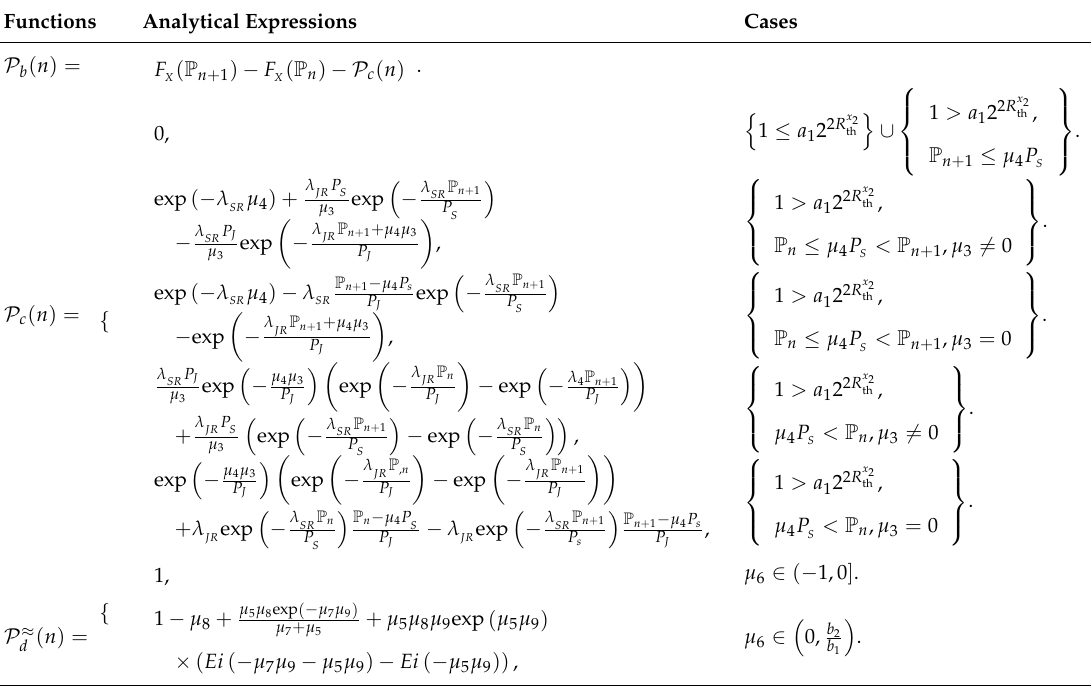
Table 2. The analytical expressions for P b ( n ) , P c ( n ) and P ≈ Functions Analytical Expressions